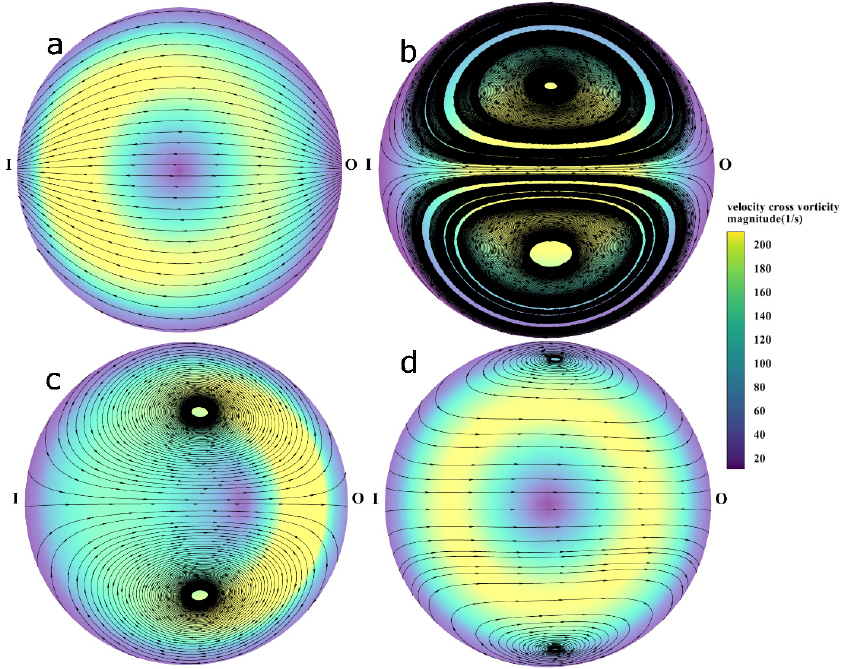
Figure 5. In the 90° channel at the conveying rate of 2.85 cm 3 /s, the profiles of the velocity cross vorticity magnitude and the projected streamlines. The slices ( a – d ) are from the second slice to the fifth slice shown in Figure 2a.